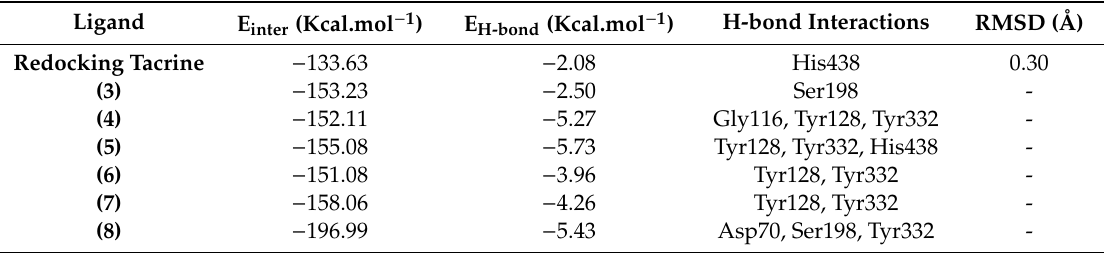
Table 4. Docking results on butyrylcholinesterase from equine serum (EqBChE). Ligand